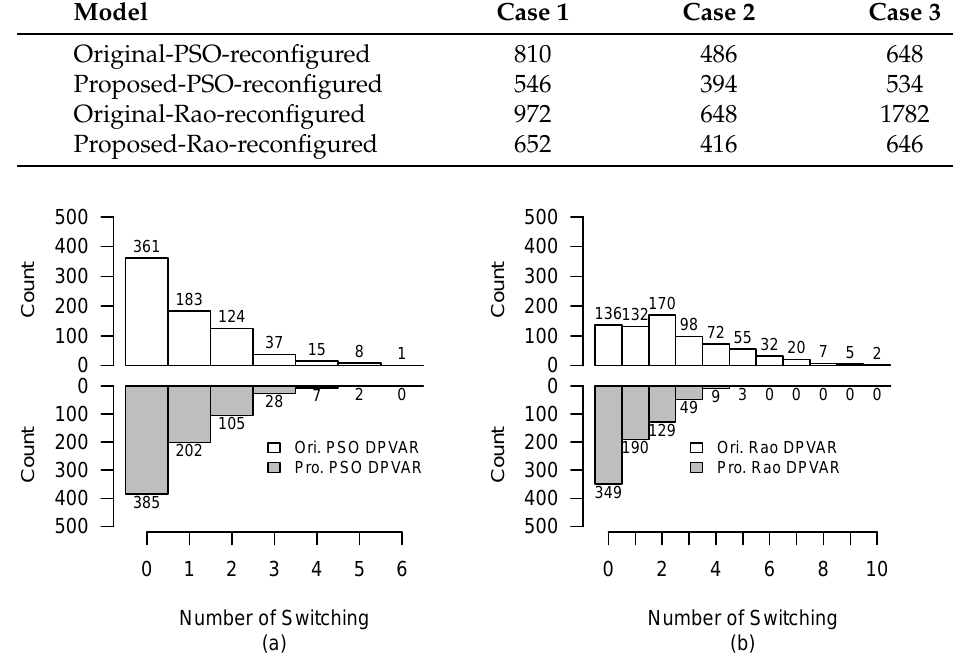
Figure 24. Comparison of switching operation of original-reconfigured and proposed-reconfigured PV arrays under Case 3 without lagged time. ( a ) PSO-reconfigured PV array. ( b ) Rao-reconfigured PV